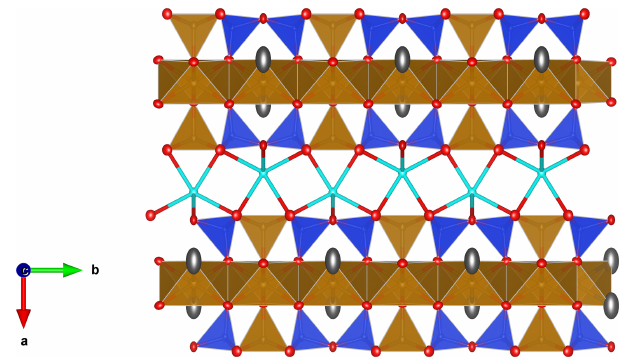
Figure 8. The crystal structure of ferroericssonite (Kampf et al., 2011) for comparison. Fe 2 + octahedra: light brown; Fe 3 + O 5 pyra- mid: light brown; SiO 4 tetrahedra: blue; Ba 2 + cations: cyan; oxy- gen anions: red; chlorine anions and/or OH groups: grey. Drawn with Vesta 3 (Momma and Izumi, 2011).